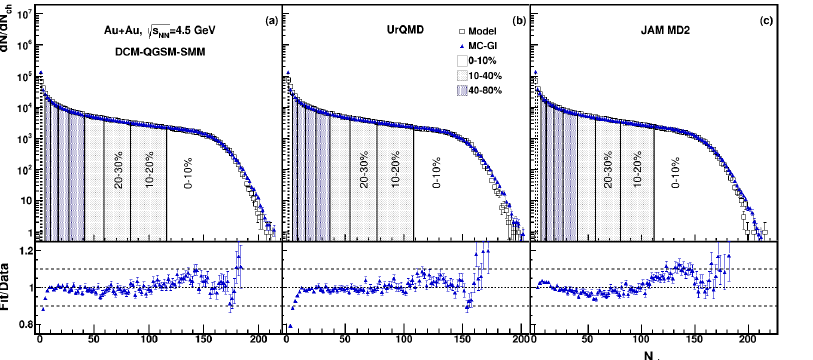
Figure 2. The reference multiplicity distributions of charged particles for Au + Au collisions at √ s NN = 4.5 GeV from the DCM-QGSM-SMM ( a ), UrQMD ( b ) and JAM MD2 ( c ) models compared to the fitted distributions using MC-Glauber approach (blue line). The 10% centrality classes defined with MC-Glauber normalization are indicated with black vertical lines. Bottom plots show the ratio of the resulted MC-Glauber fit functions to the charged particle multiplicity distribution.